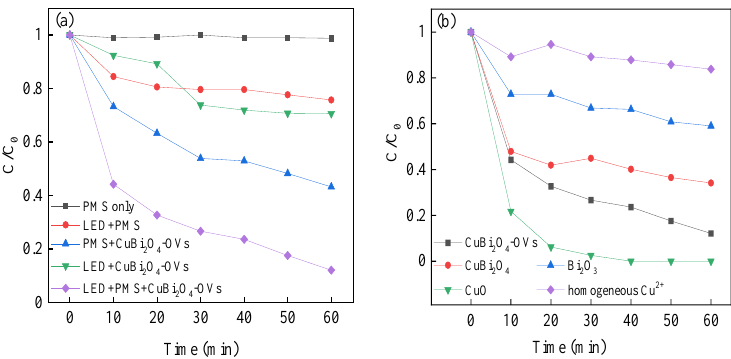
Figure 6. ( a ) Comparison of RhB degradation activity in different systems; ( b ) effect of different catalyst on RhB degradation. Reaction conditions: RhB (20 mg/L), PMS (0.4 mM), catalyst (0.5 g/L), neutral pH.